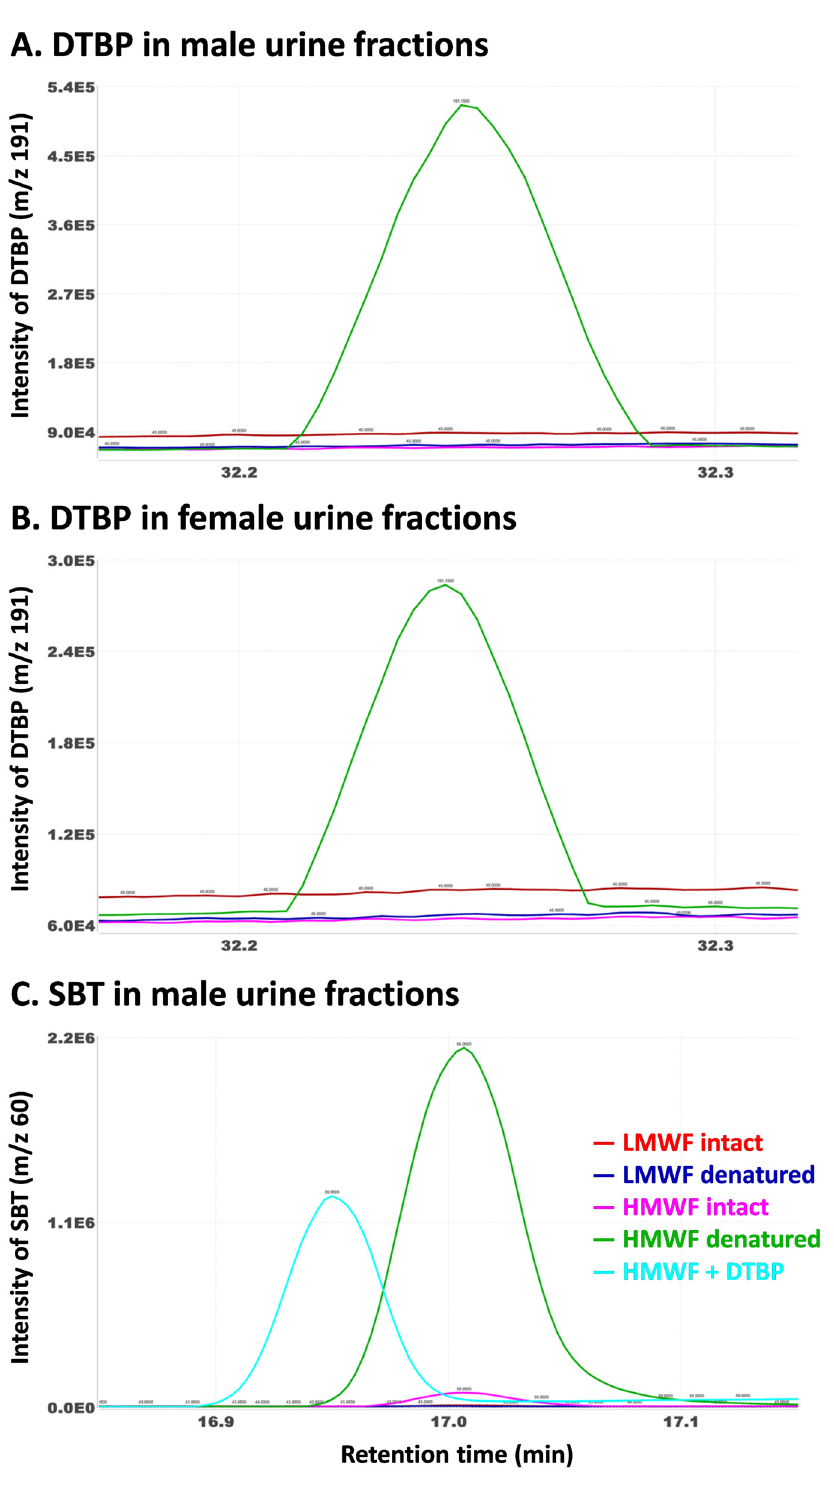
Fig 3. The distribution of DTBP in the low molecular weight fraction (LMWF; MW < 3 kDa) and high molecular weight fraction (HMWF; MW > 3 kDa) obtained from male (A) and female (B) urine, that of SBT in the male urine fractions, and the displacement of SBT by DTBP (C).